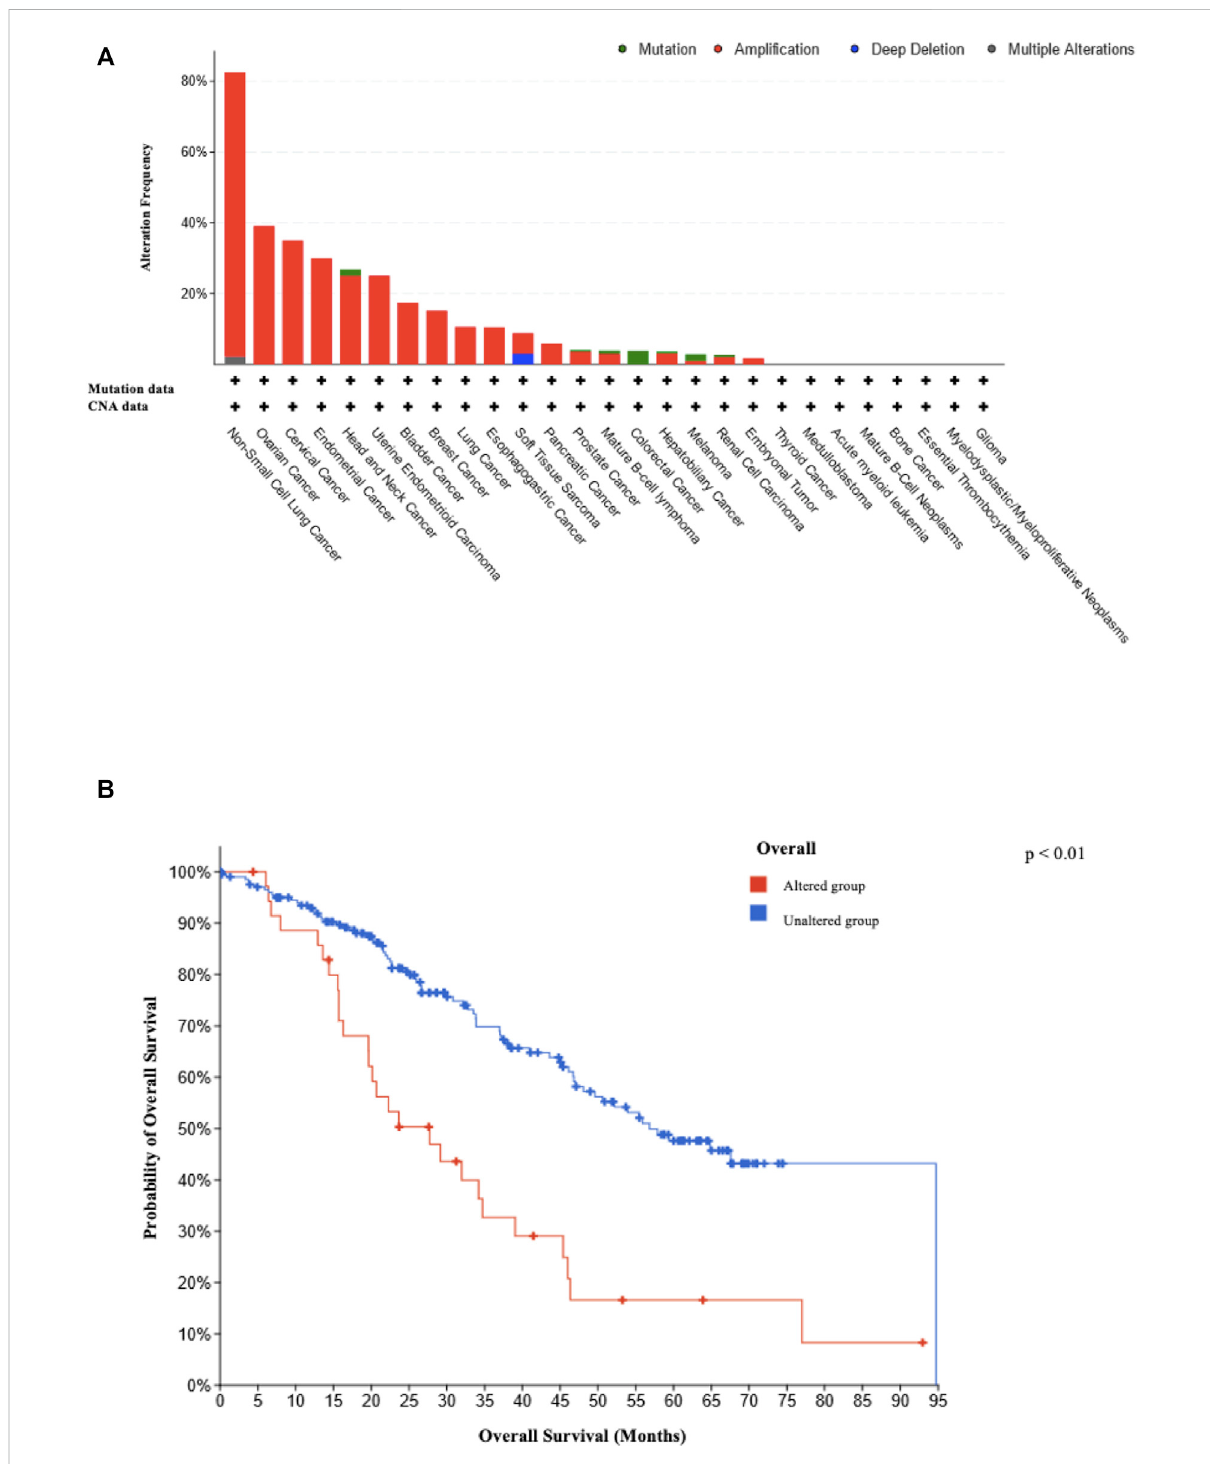
FIGURE 4 Typeandfrequencyofreported SEC62 genealterationsandrelatedsurvivalrates. (A) Typeandfrequencyof SEC62 genealterationsrecordedin the TCGA atlas from the National Cancer Institute GDC Data Portal. The analysis was performed in 86,046 cases overall from 67 different primary tumor sites on 13 July 2022. CNA = copy number alteration (B) Overall survival across all cancer entities recorded in the TCGA atlas depending on SEC62 alteration.Theanalysiswasperformedon13July2022.Two-sided p valuesareindicated,values < 0.05wereconsideredtobesigni fi